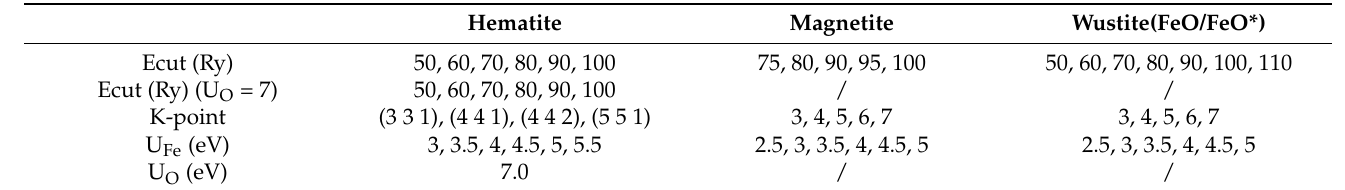
Table 1. The main parameters and values used for testing. Hematite